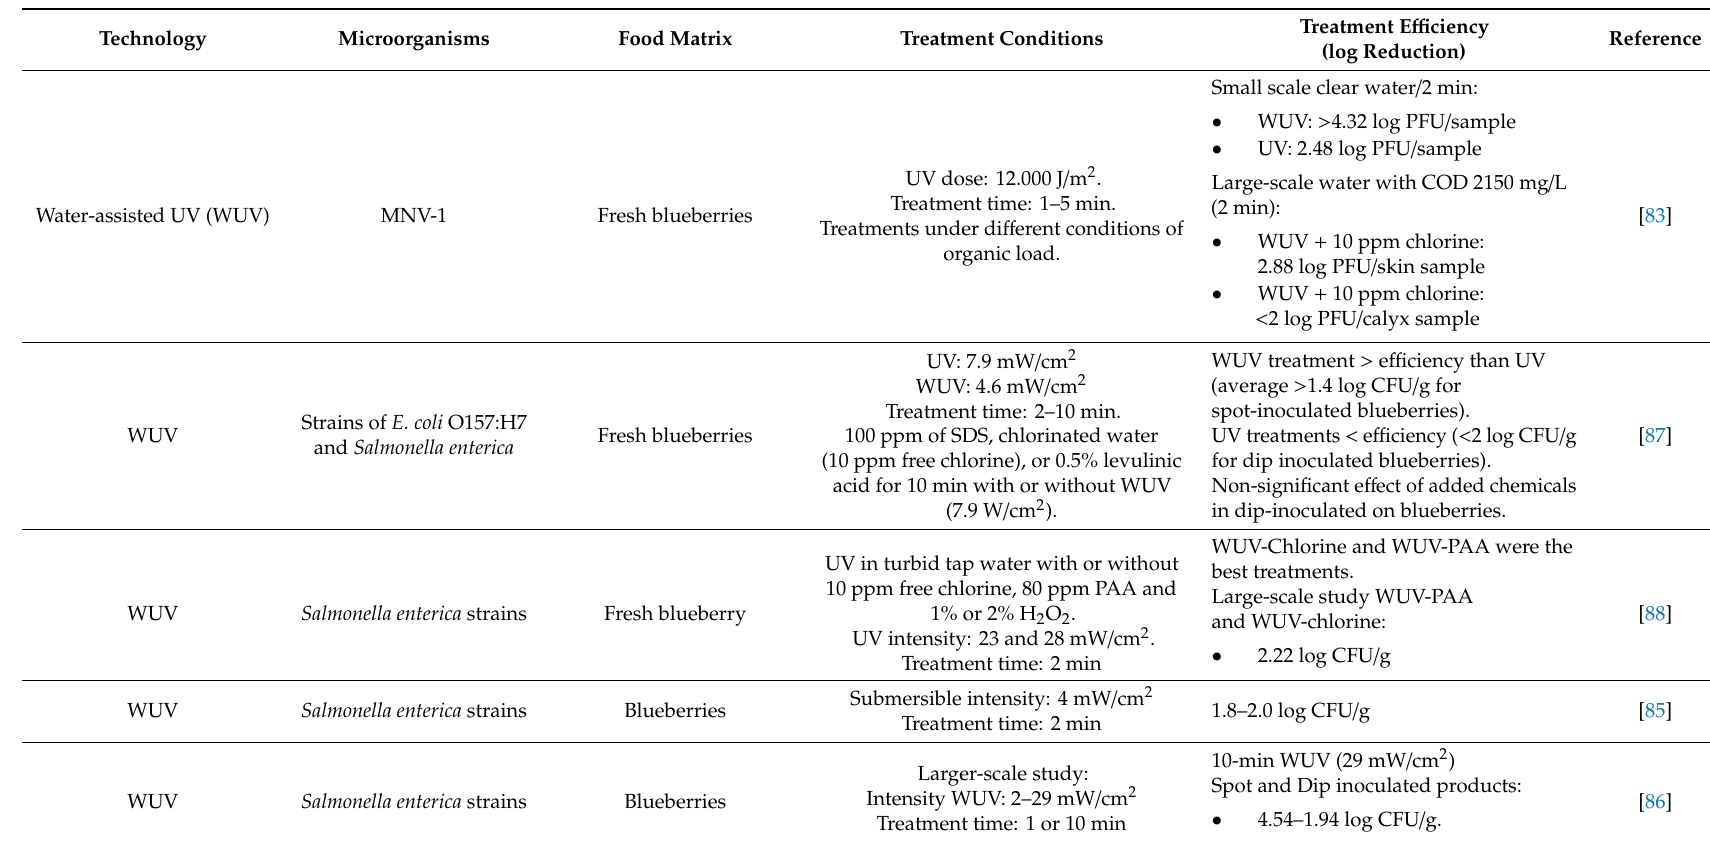
Table A3. Physical technologies used alone or in combination with antimicrobial agents for the control of microorganisms on blueberries and products derived